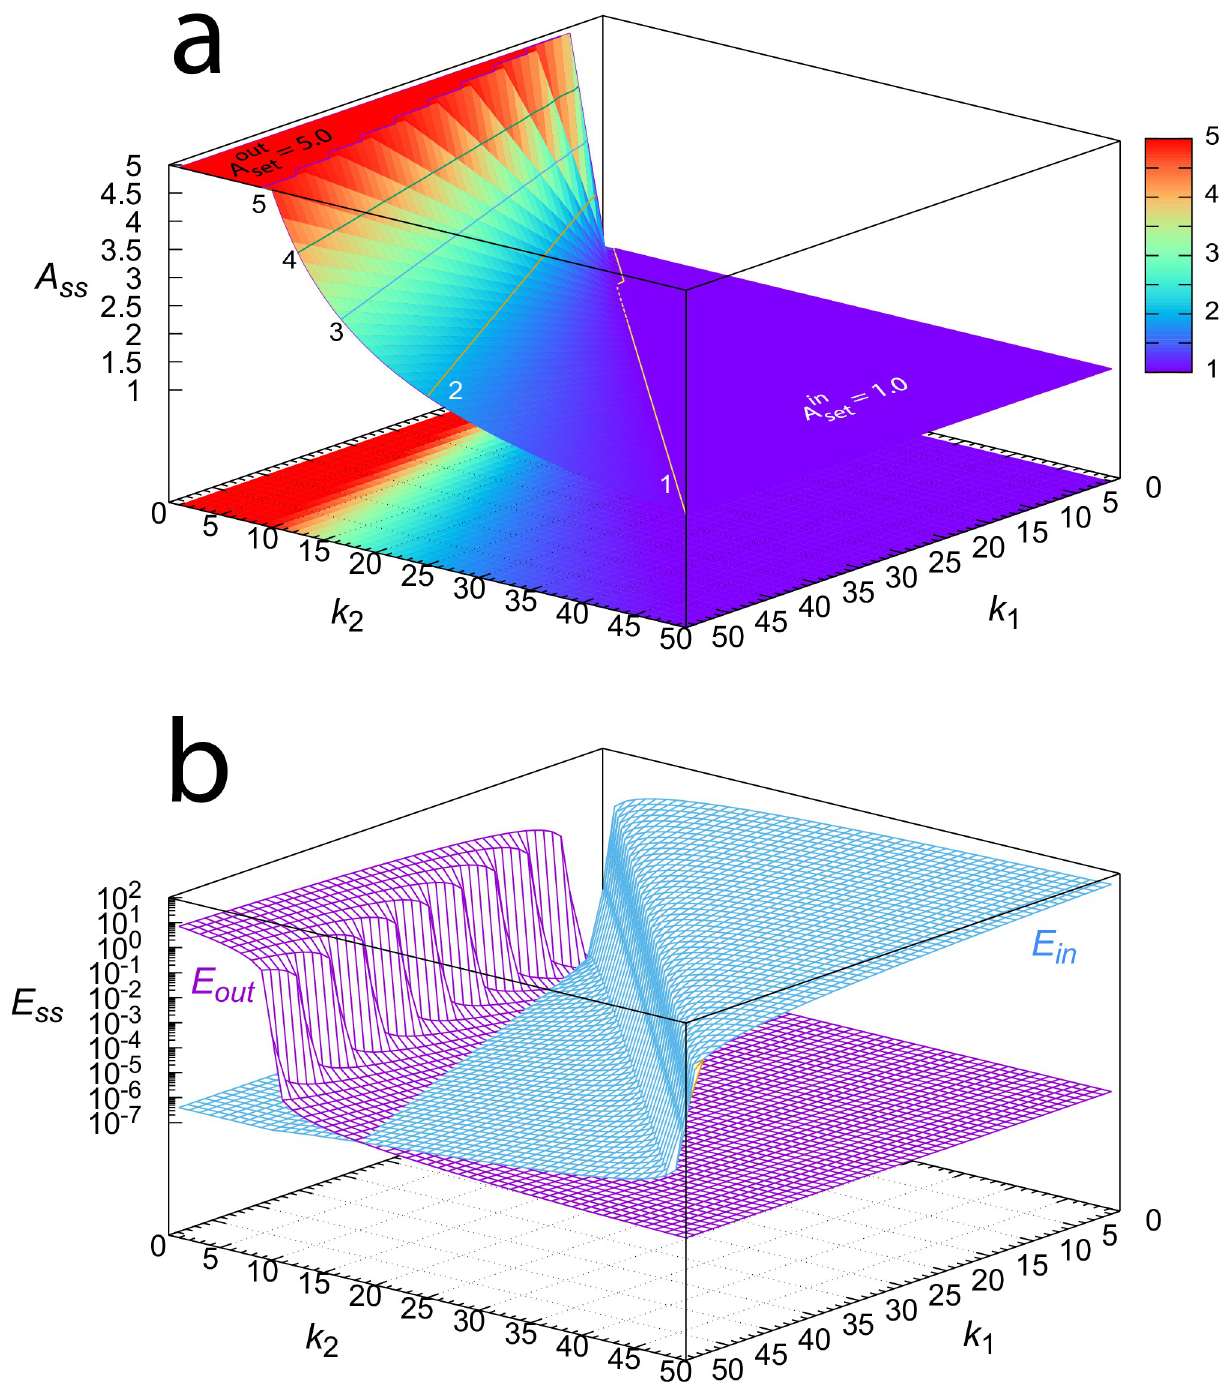
Fig 4. Steady state values of A , E out , and E in of the combined m3-m5 controllers (Fig 3) as a function of perturbation parameters k 1 and k 2 . k 1 and k 2 vary between 1.0 and 50.0 with increments of 1.0. (a) Steady state values of A . Numbers 1-5 in the plot indicate the contour lines having this value of A ss . (b) Steady state values of E out and E in . Rate constants: k 3 = 10.0, k 4 = 50.0, k 5 = 1 × 10 − 6 , k 6 = k 7 = 1.0, k 8 = 2.0, k 9 = 1.0, k 10 = 1 × 10 − 6 , K I 1 = 1.0. Initial concentrations when calculating A for each k 1 , k 2 pair: A 0 = 3.0, E = E = 0.0; integration time: 1000 time units. For an interactive visualization of the ss in out surfaces, see S1 Gnuplot.